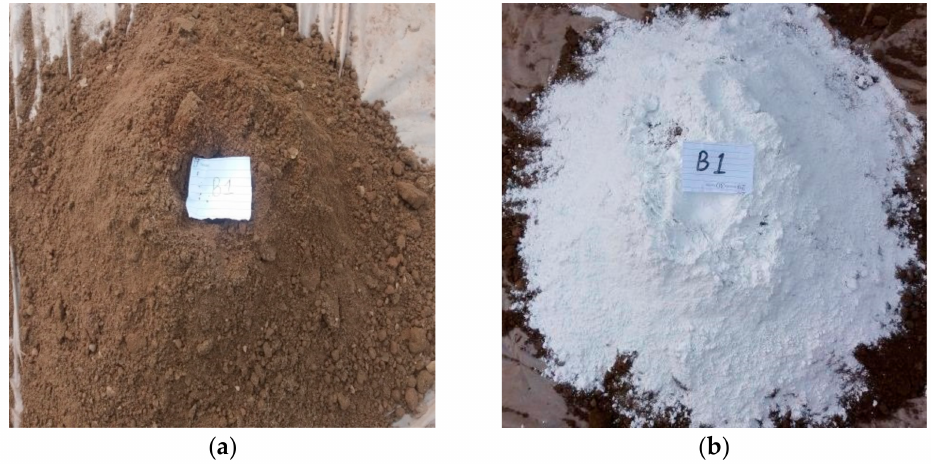
Figure 1. View of: ( a ) clay sample, and ( b ) mixing of clay and marble